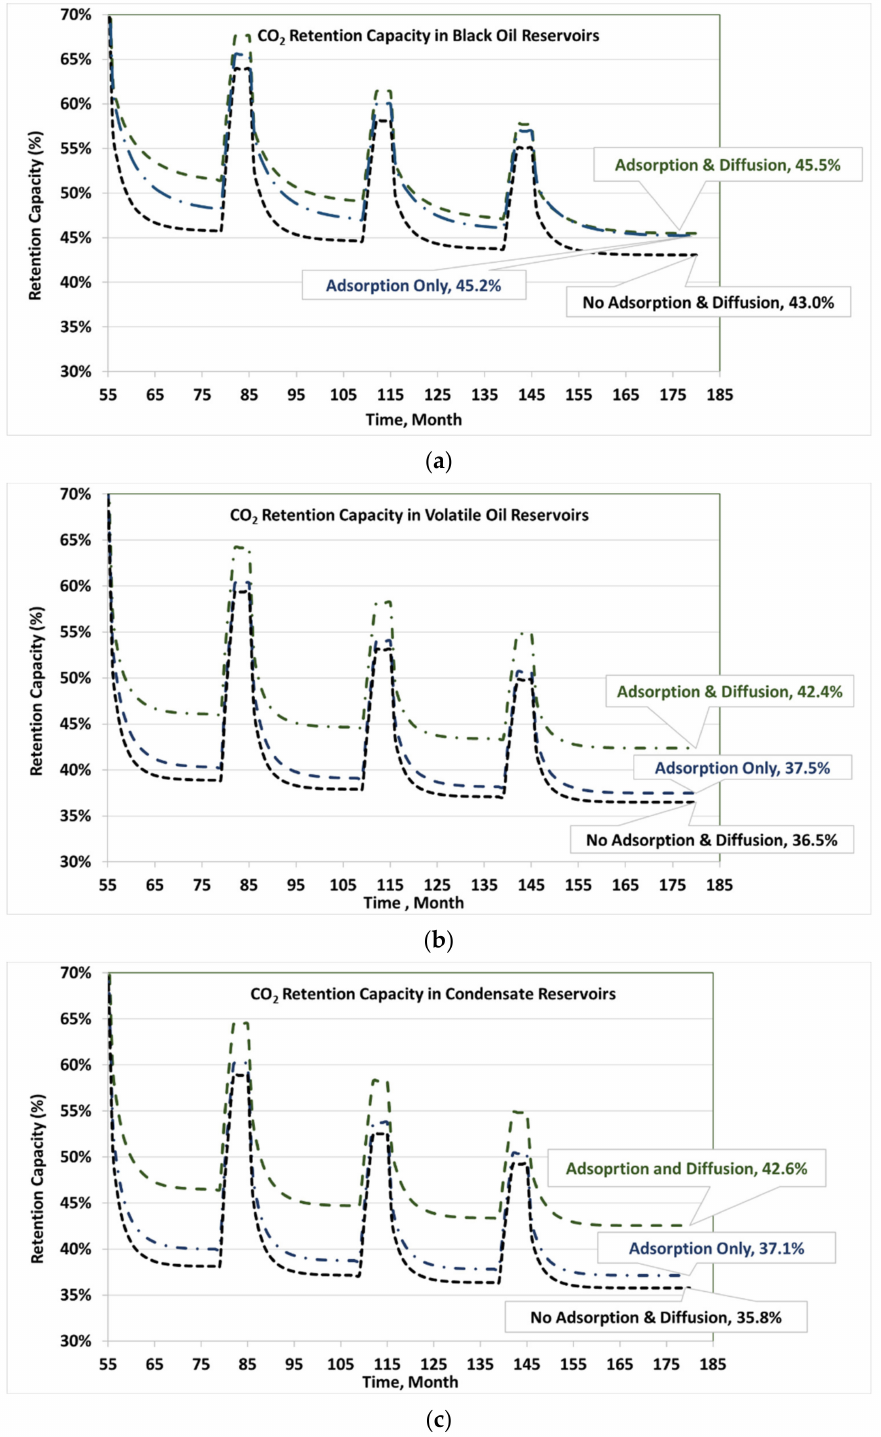
Figure 10. Retention capacity of CO 2 in the ( a ) black oil, ( b ) volatile oil, and ( c ) condensate fluid